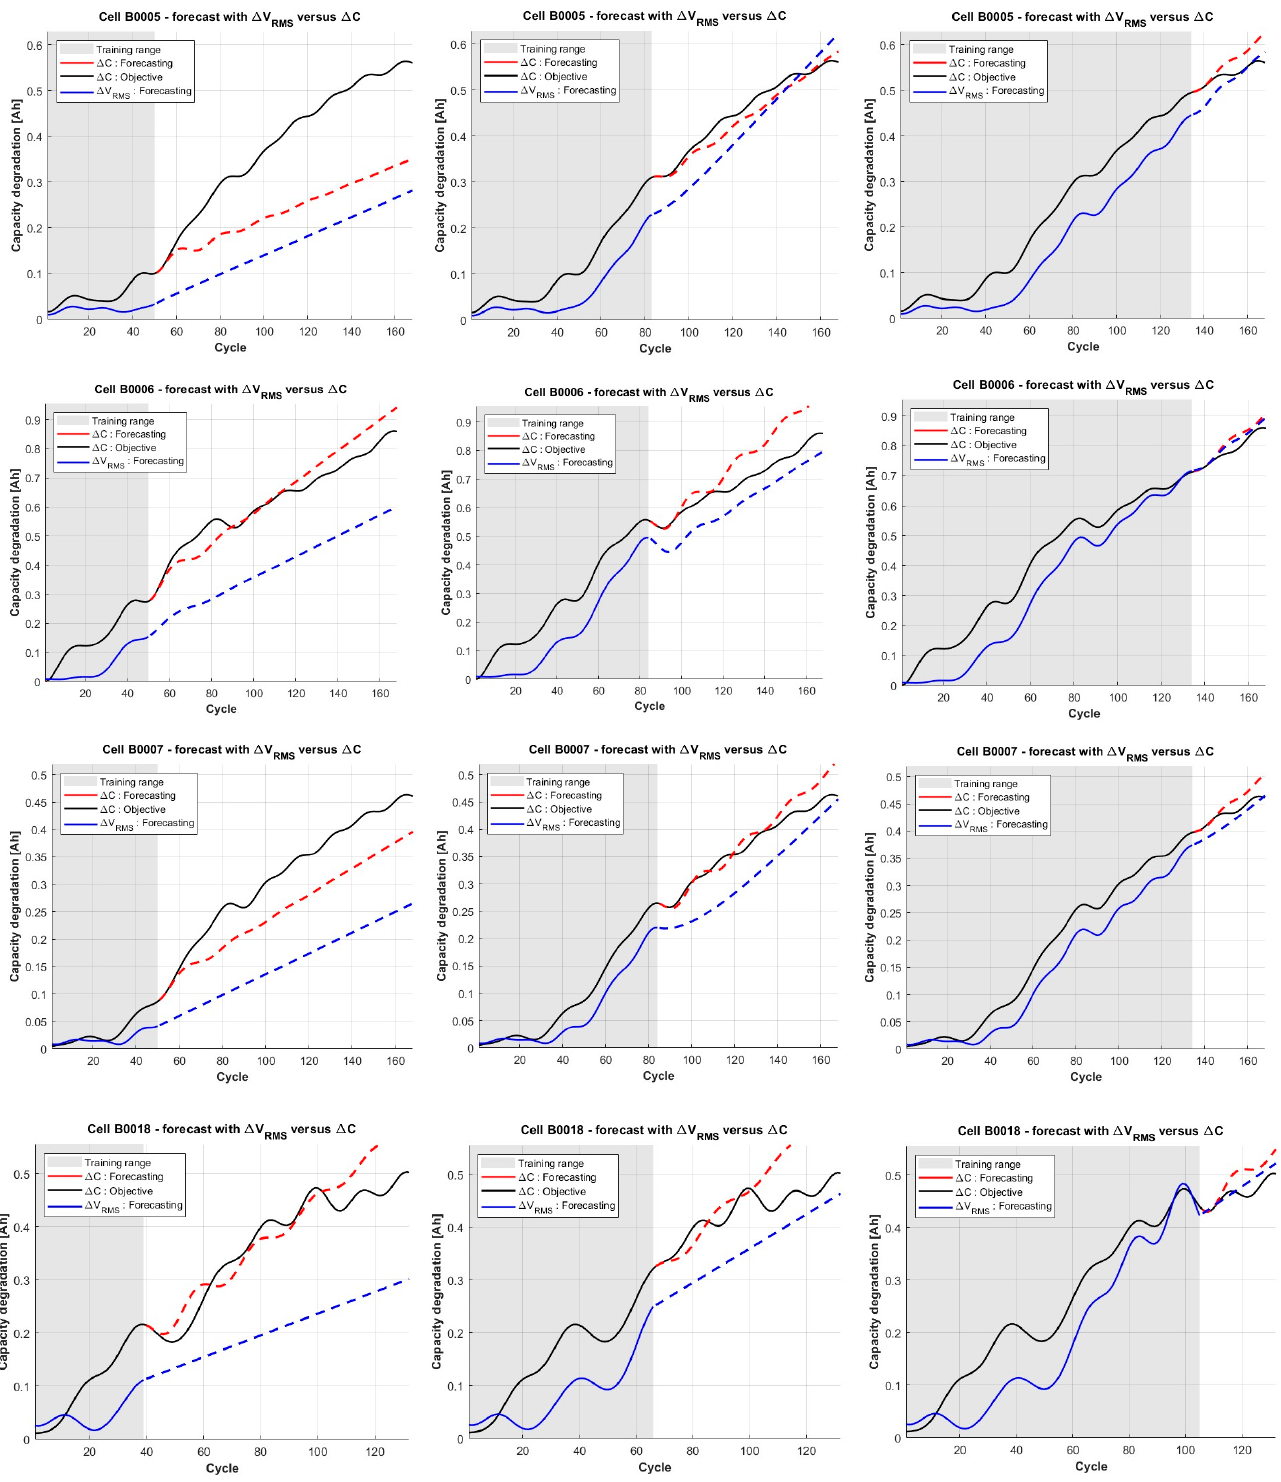
Figure 7. ARIMA predictions at different cycles for each analyzed cell with a discharge current of 2 A (C-rate of 1). Behavior of the measured capacity fade Δ C (black line, which corresponds to the objective time series), the prediction results with the proposed Δ V RMS health indicator in the scale of Δ C (blue line), and the prediction of Δ C (red line).